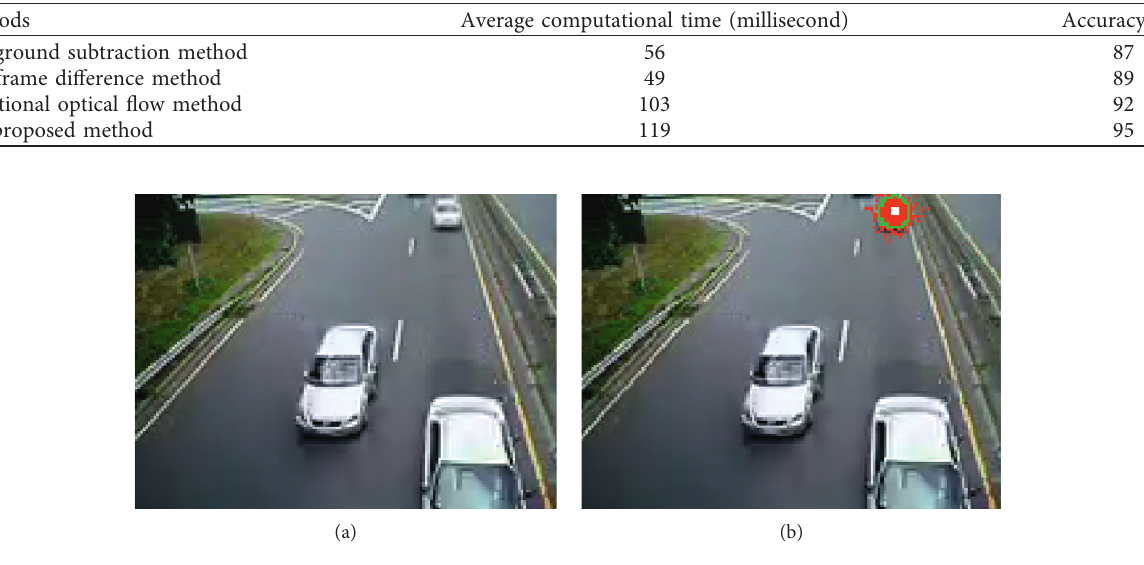
Figure 10: Tracking result of the 2 nd frame. (a) The original image. (b) Tracked vehicle image.